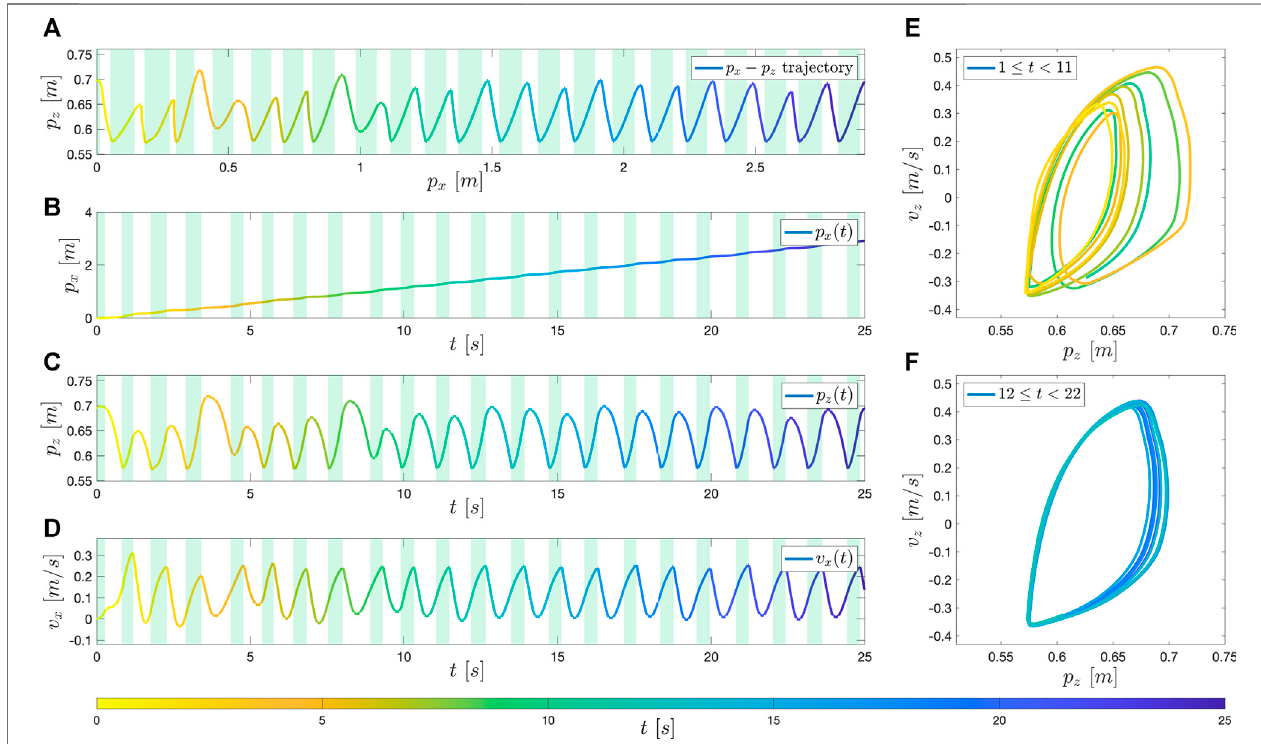
FIGURE 8 | The simulation result in the nominal condition. (A) shows the trajectory of the pelvis in the sagittal plane (X-Z plane). (B – D) shows the p x , p z , v x of the pelvis over time. (E) and (F) are the phase plots of the pelvis in Z-coordinate: (E) in an earlier phase (1 s ≤ t ≤ 11 s), and (F) in a later phase (12 s ≤ t ≤ 22 s).